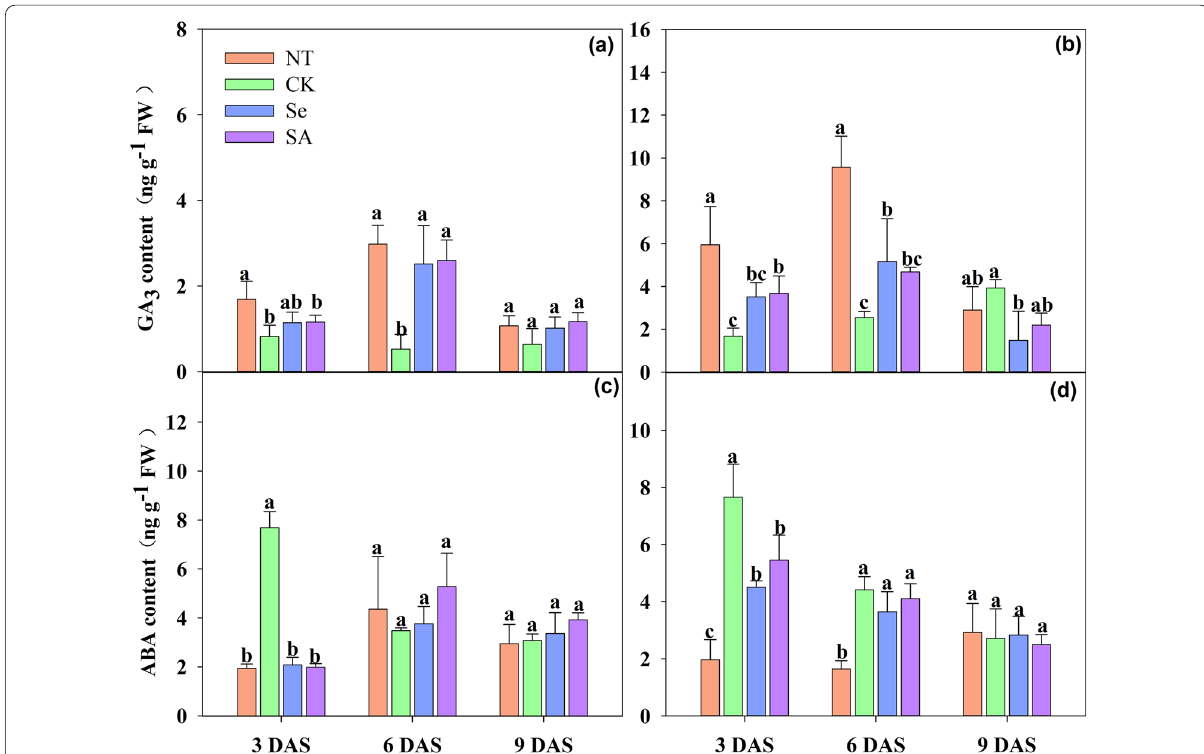
Fig. 5 GA 3 and ABA content of primed and non-primed rice seeds under control temperature and chilling stress. a, c EZ18; b, d LY287; a, b GA 3 content; c, d ABA content DAS, days after sowing; EZ18, ezao18; LY287, liangyou287; NT, no priming-normal temperature control; CK, no priming-chilling stress; Se, Selenium priming-chilling stress; SA, Salicylic priming-chilling stress. GA, gibberellin acid; ABA, abscisic acid. Error bars indicate standard error (n 3). Different lowercase letters denote statistical differences at the 5% level according to LSD test among four treatments = within the same DAS of the same